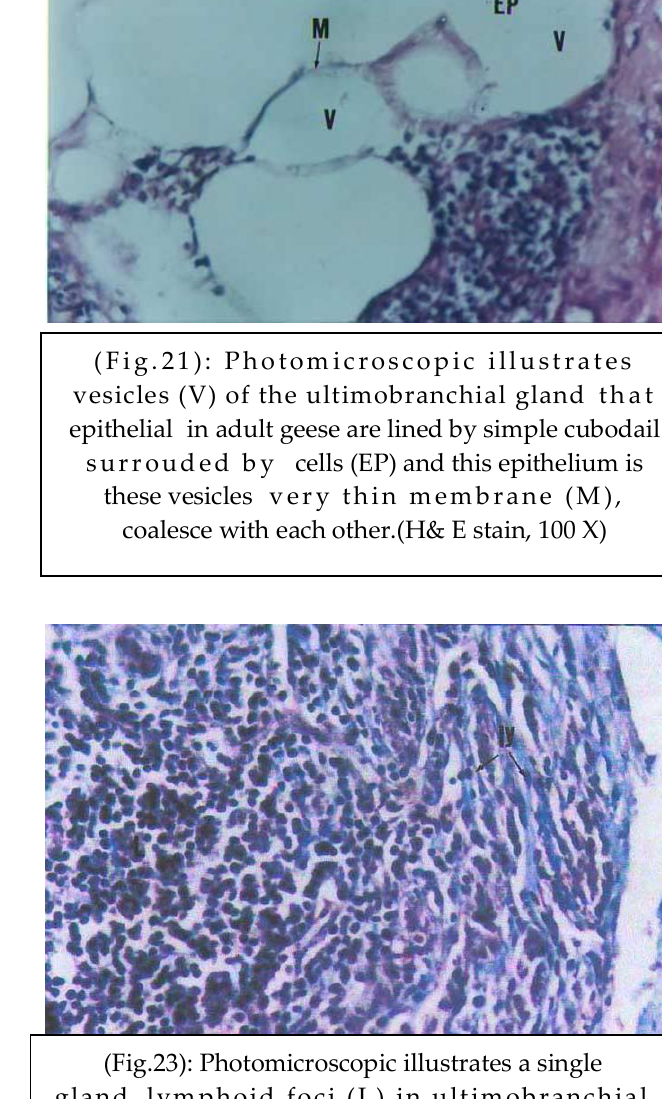
gland of adult geese and this cyst stores an staining